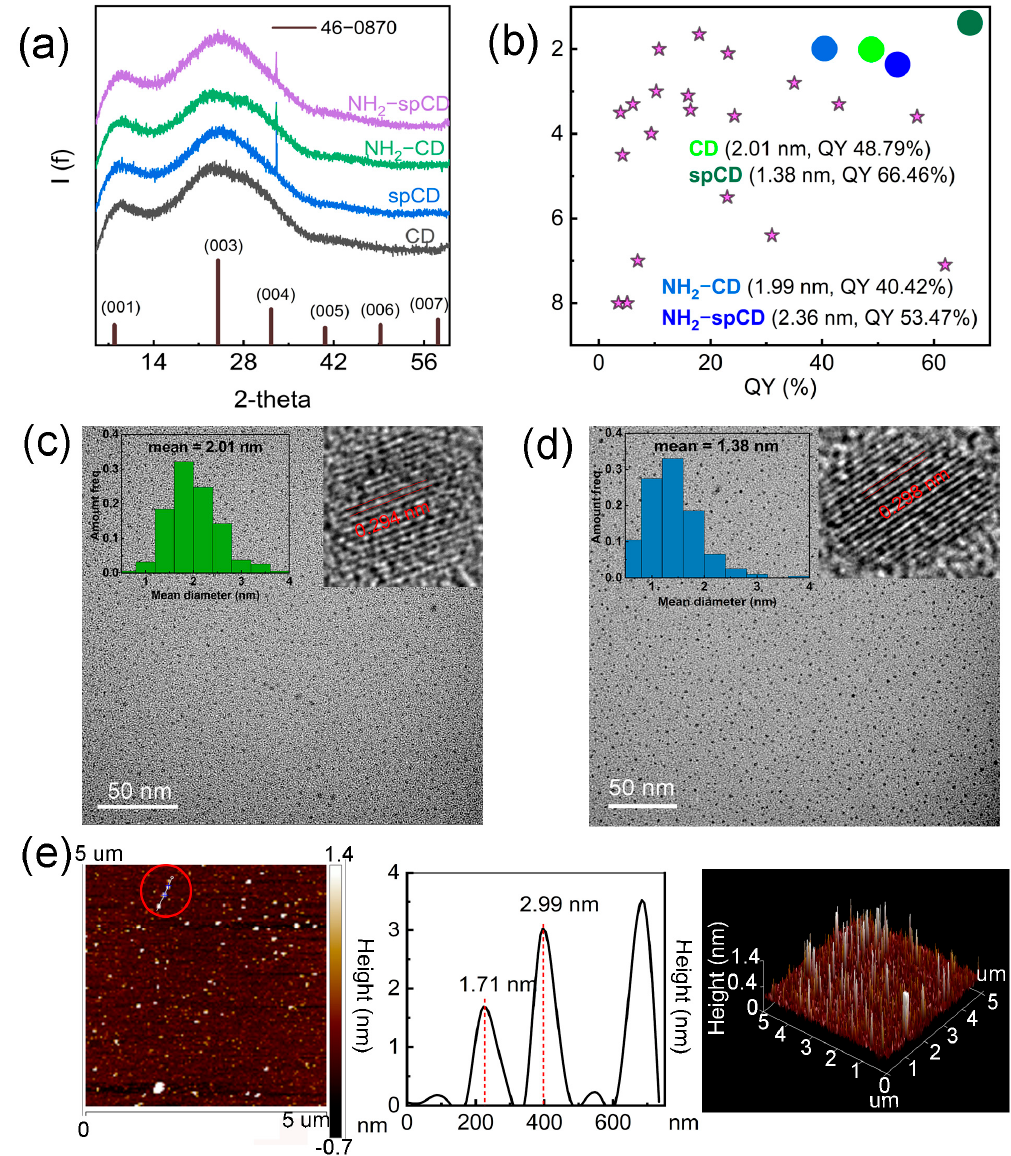
Figure 2. ( a ) XRD spectra of CD, spCD, NH 2 –CD, NH 2 –spCD and the PDF standard card, ( b ) Diameters and QY values for other works and this work [13,15,16,22,26,27,28,40,41,53–63] ( c ) TEM and HRTEM of CD and ( d ) spCD, ( e ) AFM of NH 2 –spCDs (left: planar graph of NH 2 –spCDs; The picture was a 5 × 5 μ m section of the sample while the color bar at the right represents the height value among the section. middle: particle height marked at the left graph in red circle, right: 3D image corresponding to the left graph).